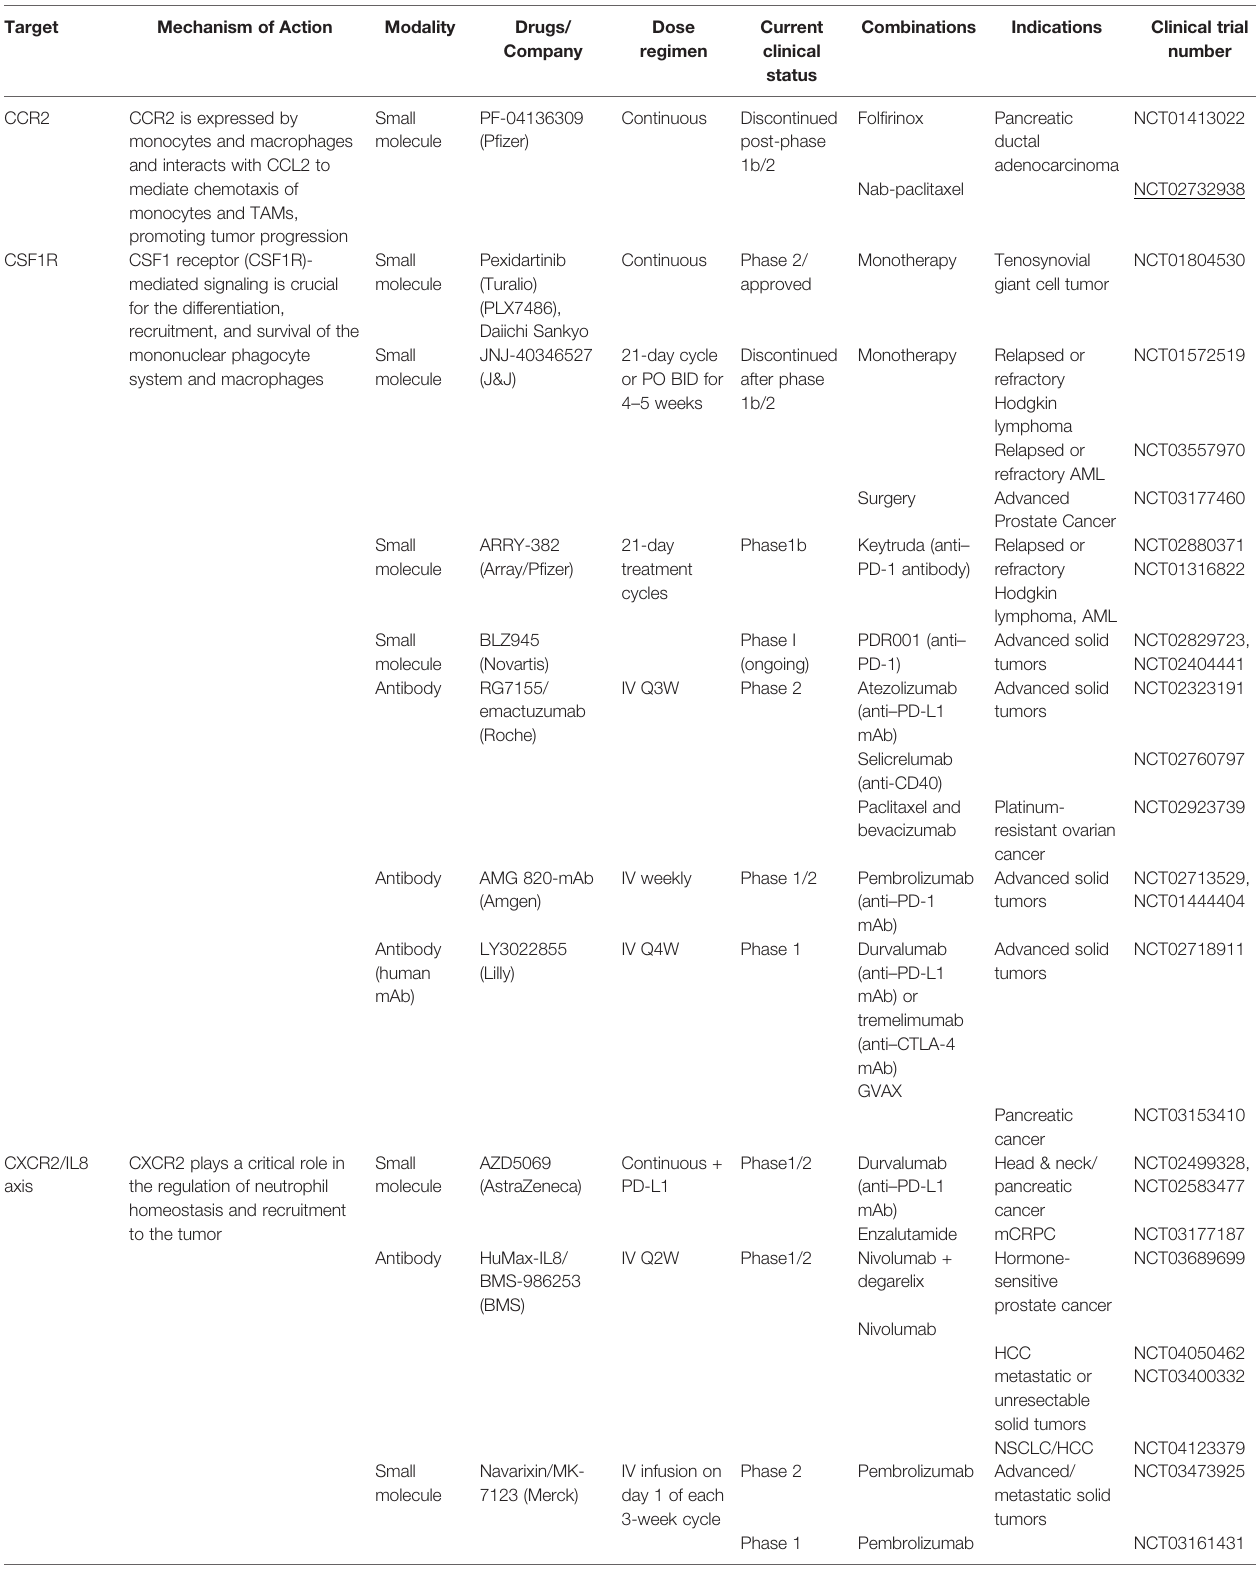
TABLE 1 | Myeloid and NK target therapies tested in clinical